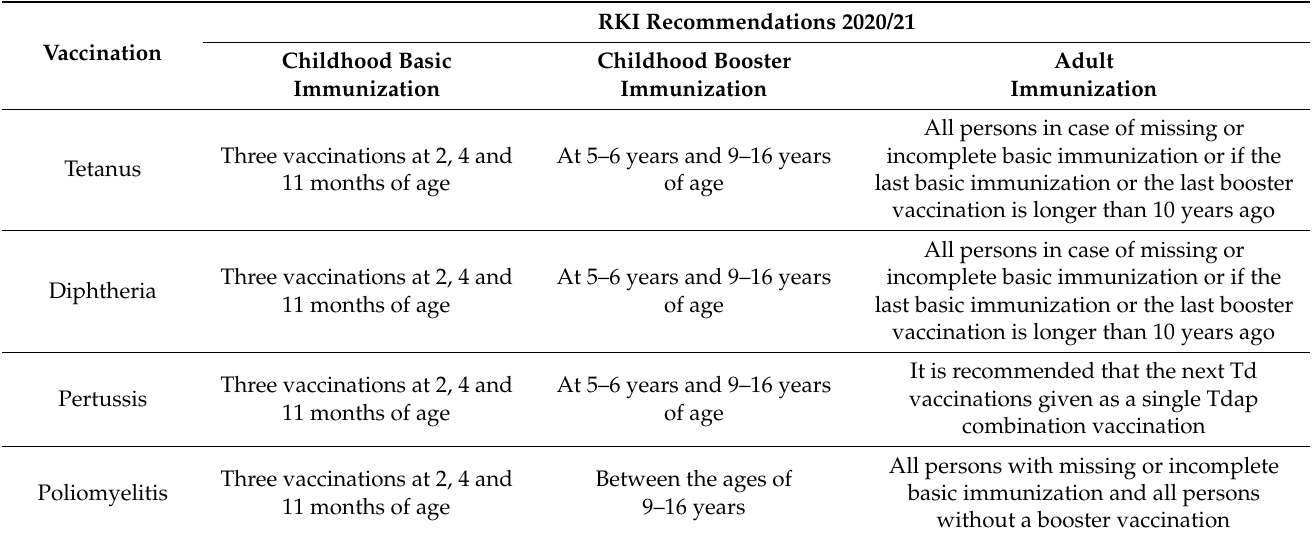
Table 1. German national recommendations by the Standing Committee on Vaccination (STIKO) of the Robert Koch Institute (RKI) for tetanus, diphtheria, pertussis and poliomyelitis vaccination [37].